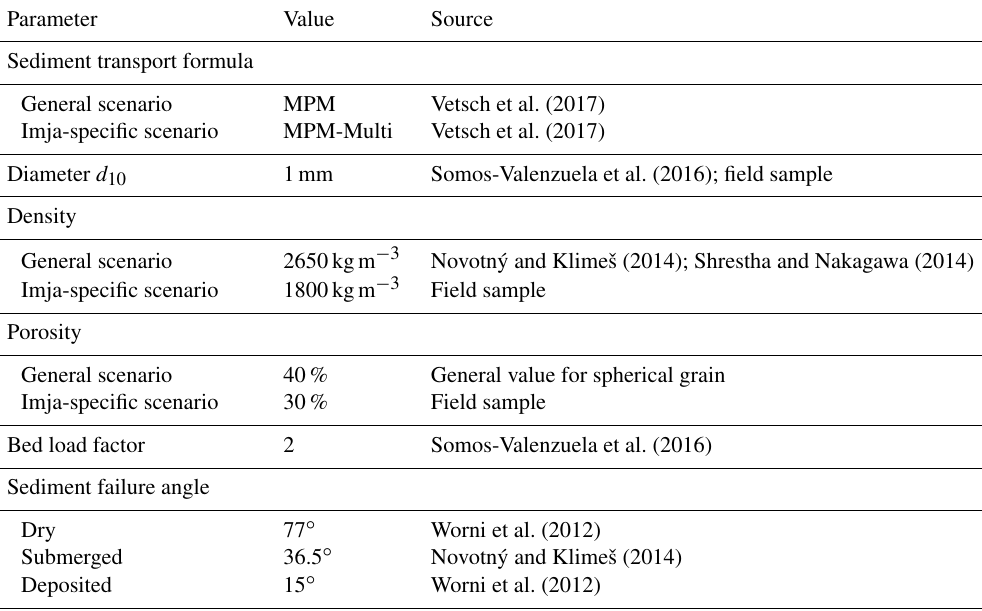
Table 1. Geomorphic parameters used to define the soil matrix of the terminal moraine in BASEMENT simulations.